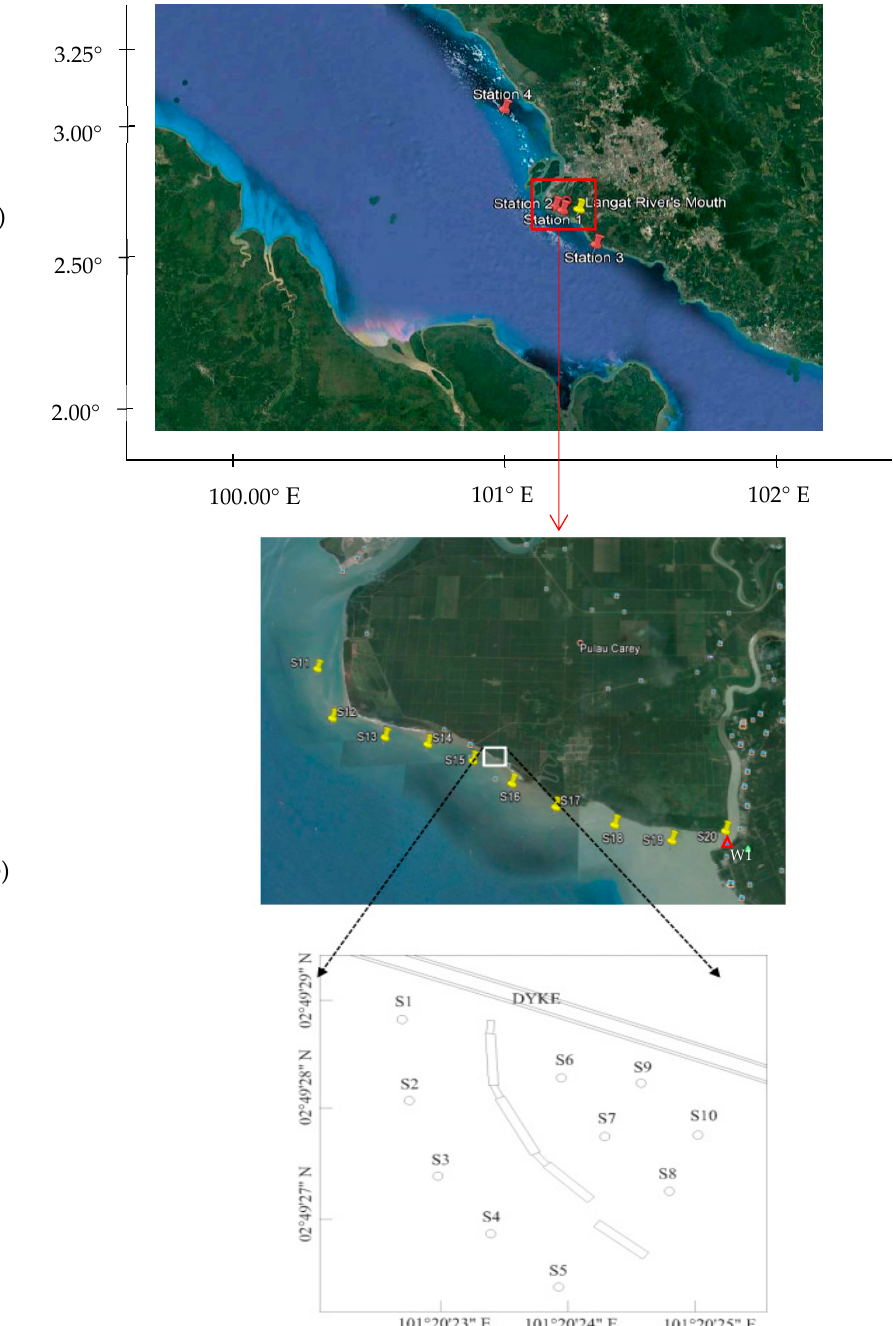
Figure 4. ( a ) Locations of AWAC and OBS-3A units within the study site, ( b ) location of water and bed samples in the study site (S = soil sample, W = water sample and discharge).